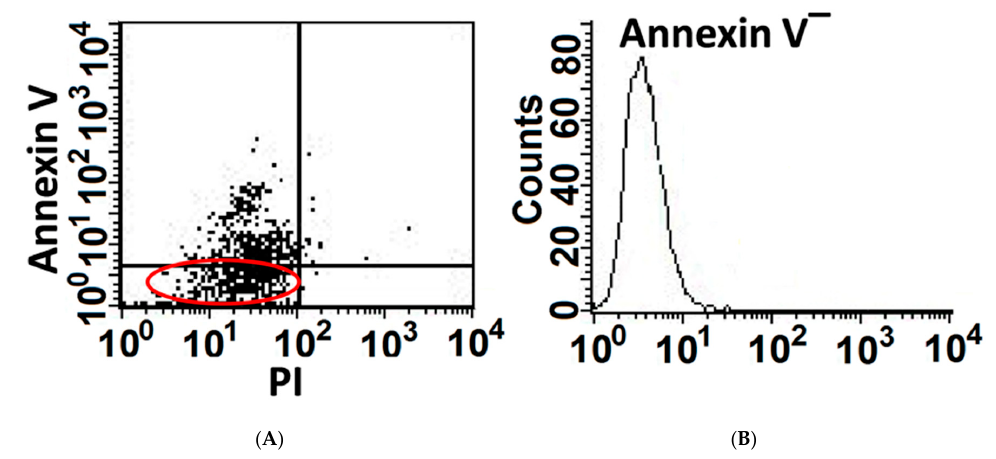
Figure 1. A portion of AECs, mouse lung epithelial (MLE) cells, exposed to bleomycin resist apoptosis and upregulate cell-survival genes. Mouse lung epithelial (MLE12)-cell line following bleomycin (BLM) exposure (200 mU, 1 h). Flow cytometry analysis of Annexin-v staining ( A Left panel) and following cell sorting of Annexin V-negative cell population ( B Right panel, Annexin V ( − ) ). Concomitantly, annexin-V ( − ) cells showed the upregulation of survival genes which are known to be expressed in response to oxidative-stress and DNA-damage, such as GADD45 , P21 and others, but also of genes involved in apoptosis regulation, such as ATM , IAP ’s and survivin (Table 1). Table 1. Mouse lung epithelial (MLE) cells exposed to bleomycin upregulate cell-survival genes. Apoptosis superarray membranes spotted with gene specific cDNA. Fragments of 96 apoptosis and survival related genes were with cDNA probes synthesized from three total RNA samples corresponding to cultured Annexin V ( − ) MLE cell sorted population vs. control/saline-treaded MLE cells (Ctrl). The relative expression levels of the various genes were estimated by comparing signal intensity to RPLA 13A housekeeping genes and then quantitated by densitometry after background subtraction. p < 0.05, n = 3.